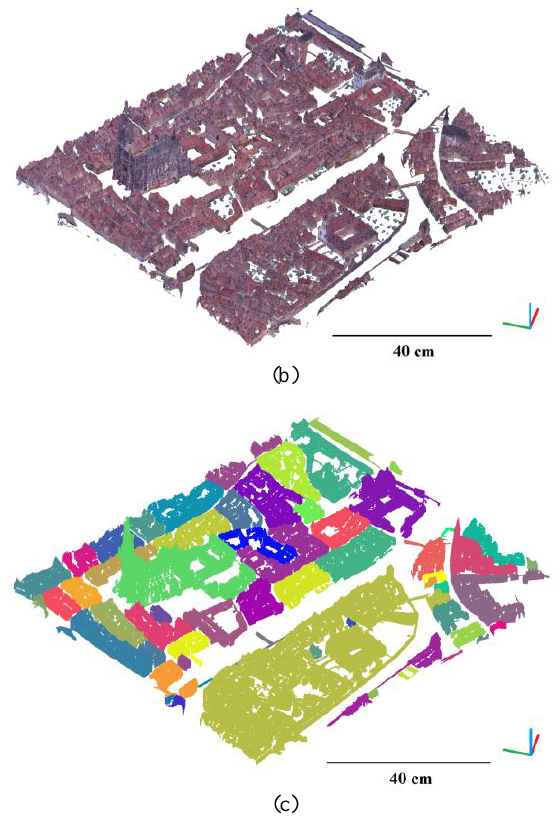
Figure 4. Segmentation into building blocks: (a) ground points; (b) off-ground points; (c) result of block segmentation (one colour per